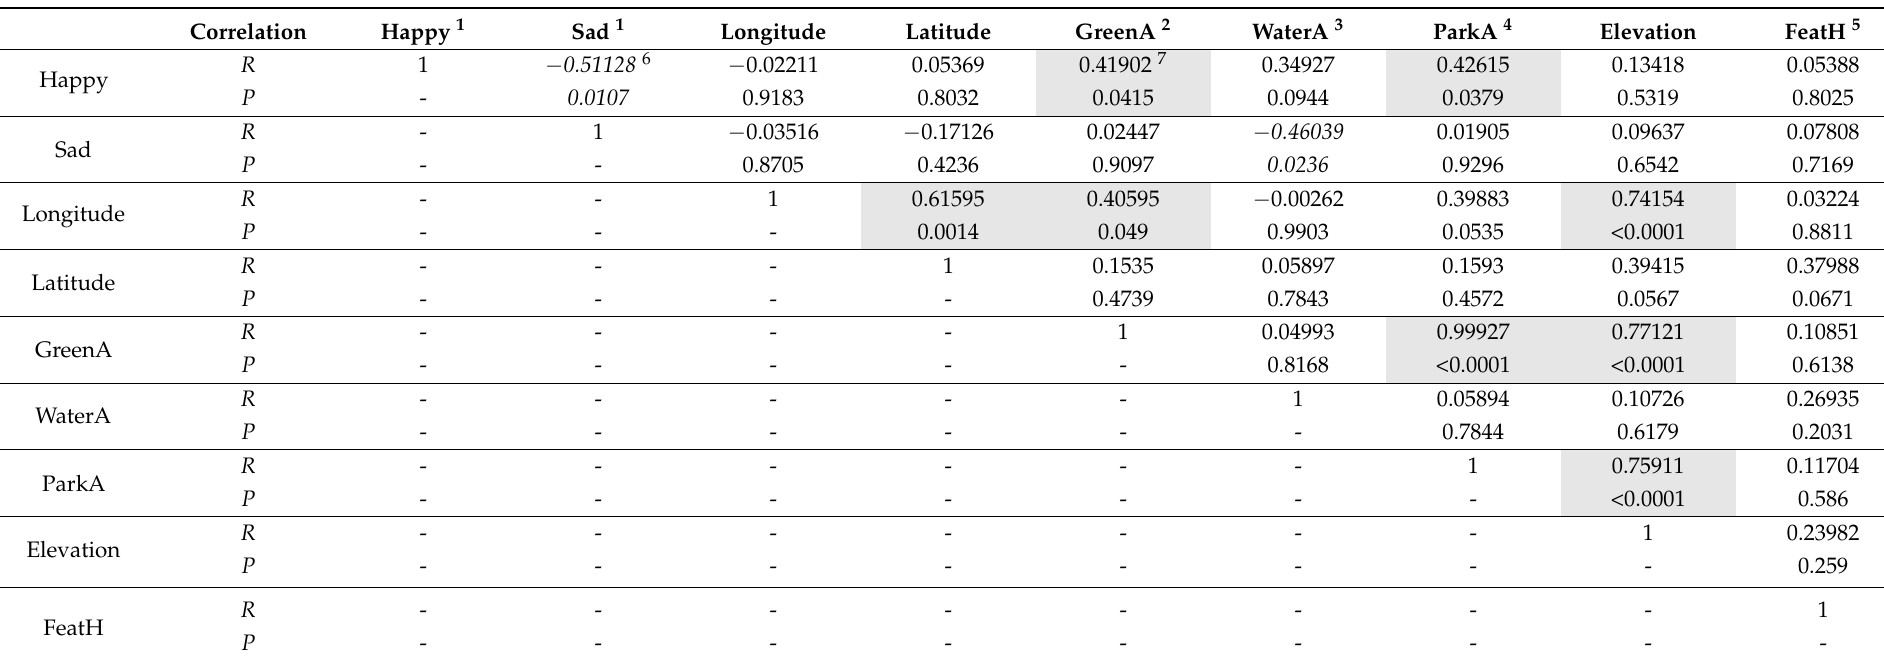
Note: 1 happy and sad scores are transformed as logarithm; 2 GreenA, green land area; 3 BlueA, aquatic area; 4 ParkA, intact area of an urban forest park; 5 FeatH, height of surface feature; 6 values in white font and black background indicate a significantly negative correlation; 7 values in italic font and light gray background indicate a significantly negative